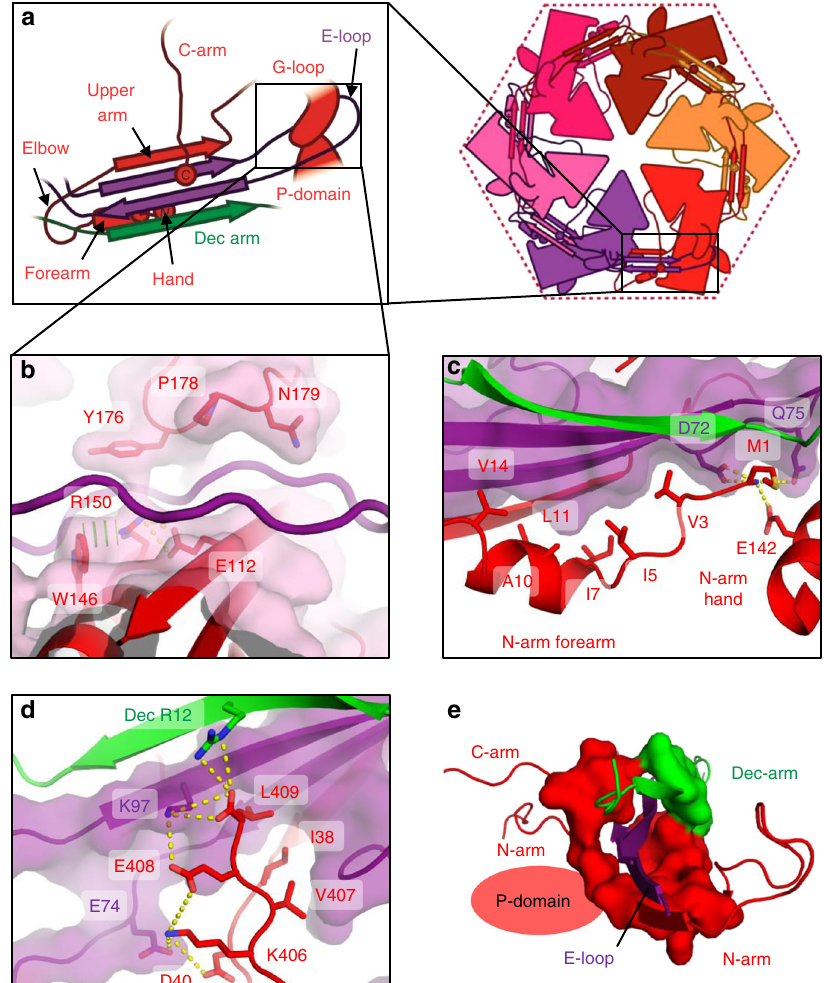
Fig. 5 Lasso interactions stabilizing the E-loop. a Diagrams depicting interactions of the MCP E-loop (purple) with a neighboring MCP subunit (red) and Dec-arm (green). b The E-loop lasso (purple) is stabilized by the G-loop and P-domain of a neighboring subunit (red). c The N-arm forearm and hand bind underneath an adjacent E-loop. d The C-arm binds on top of all four strands of the E-loop β -sheet. e The β -hairpin of the E-loop (purple) is stabilized by a closed ring consisting of the MCP N- and C-arms (red), and the Dec-arm